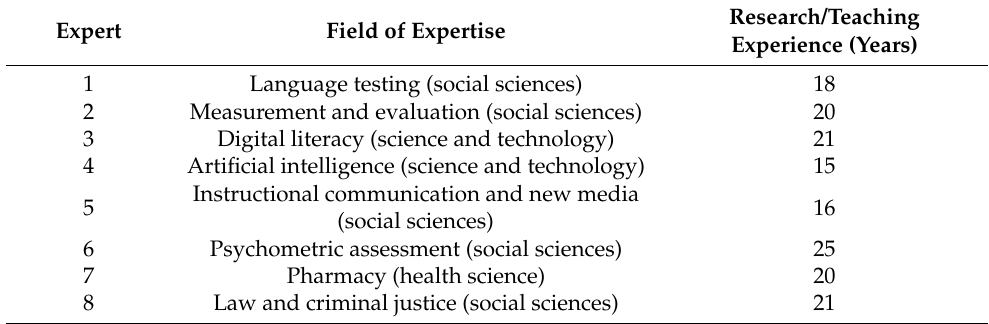
Table 2. Judges and field of expertise.